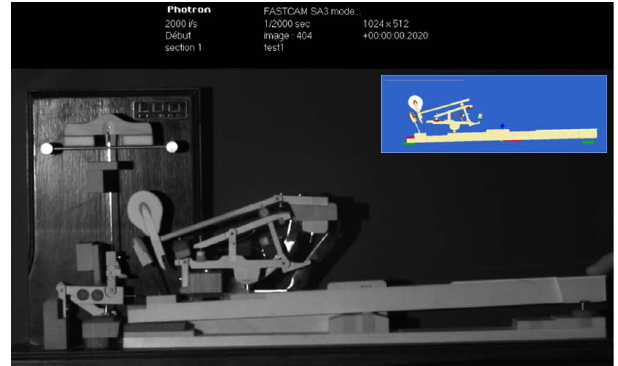
Figure 20. Simulation of the collision of a bus or a car into the TMA.